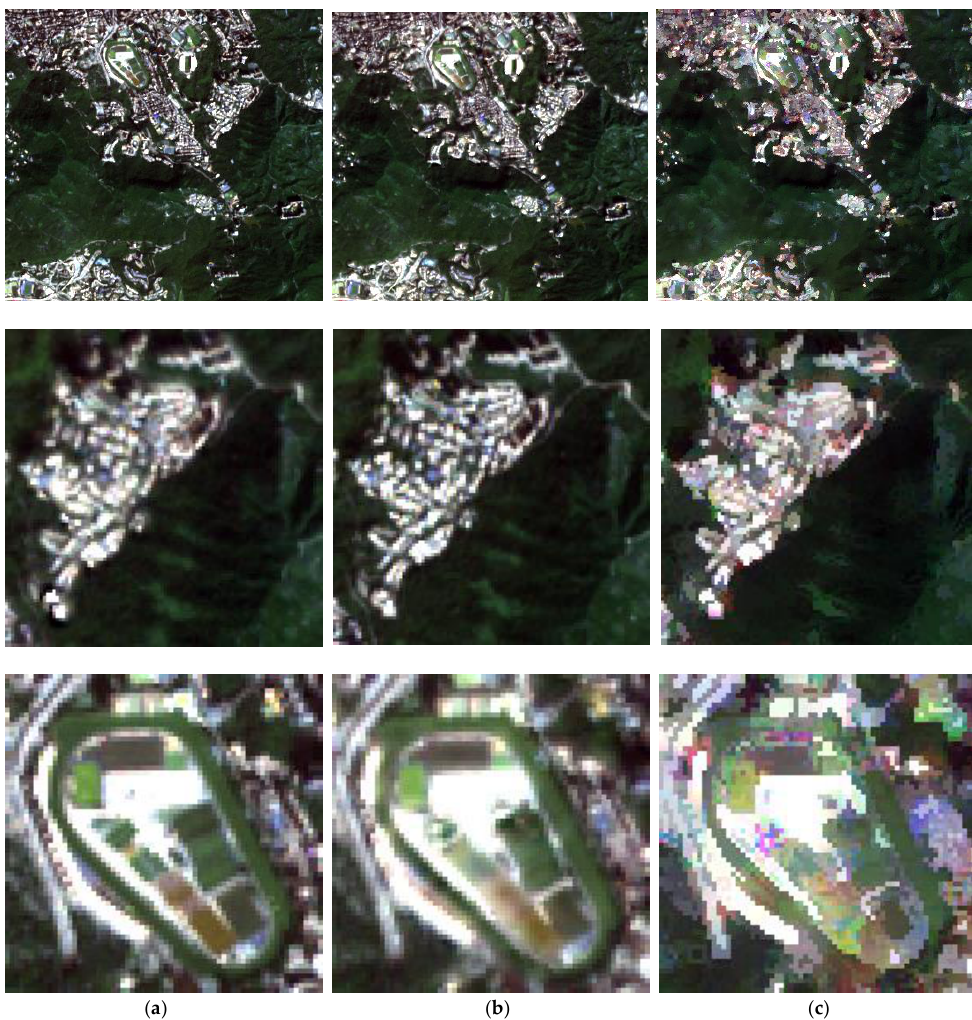
Figure 8. Fusion results for the Hong Kong Island on 14 February 2017, zoomed to a piece of the unchanged area with half urban and half vegetation cover (images in the 2nd row) and the racecourse with notable changes (images in the 3rd row). ( a ) Sentinel-2 at 10 m; ( b ) fused image at 10 m by HNN-SPOT; ( c ) fused image at 10 m by STARFM.